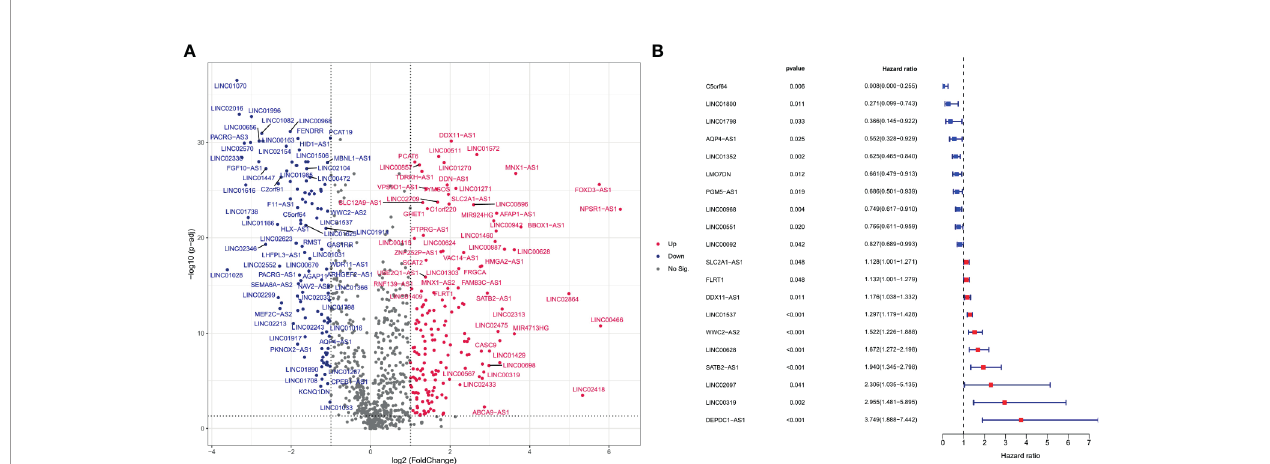
FIGURE 1 | Differentially expressed ferroptosis-related lncRNA between LUAD and normal samples (log2 fold change>2, adjusted p-value < 0.01). Compared with normal samples, 49 ferroptosis-related lncRNAs were upregulated and 43 ferroptosis-related lncRNA downregulated in LUAD samples. (A) is a volcano map for differentially expressed ferroptosis-related lncRNAs. Red dots represent signi fi cantly upregulated expressed genes and green dots represent signi fi cantly downregulated expressed genes. (B) indicates the HR (95% Cl) and p-value of selected lncRNAs by univariate Cox proportional hazards. Blue dots represent protective factors, and red dots represent risk factors.